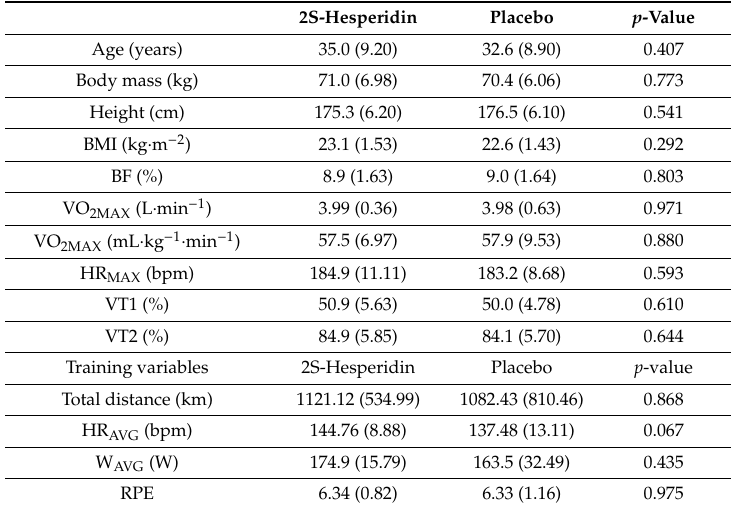
Table 1. Baseline general characteristics and training variables of